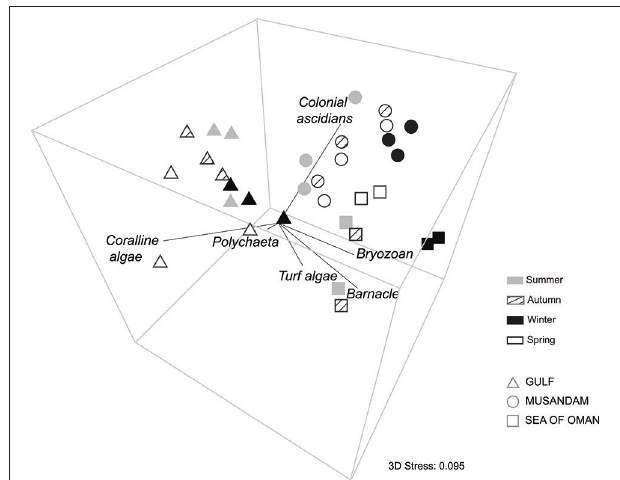
FIGURE 2 | Three-dimensional plot of non-metric multidimensional scaling ordination (nMDS) illustrating the spatial and seasonal variation in benthic community structure across three Arabian water bodies. The vector overlay shows the strength and direction of individual benthos’ Pearson rank correlations (restricted to those with r > 0.5 for any